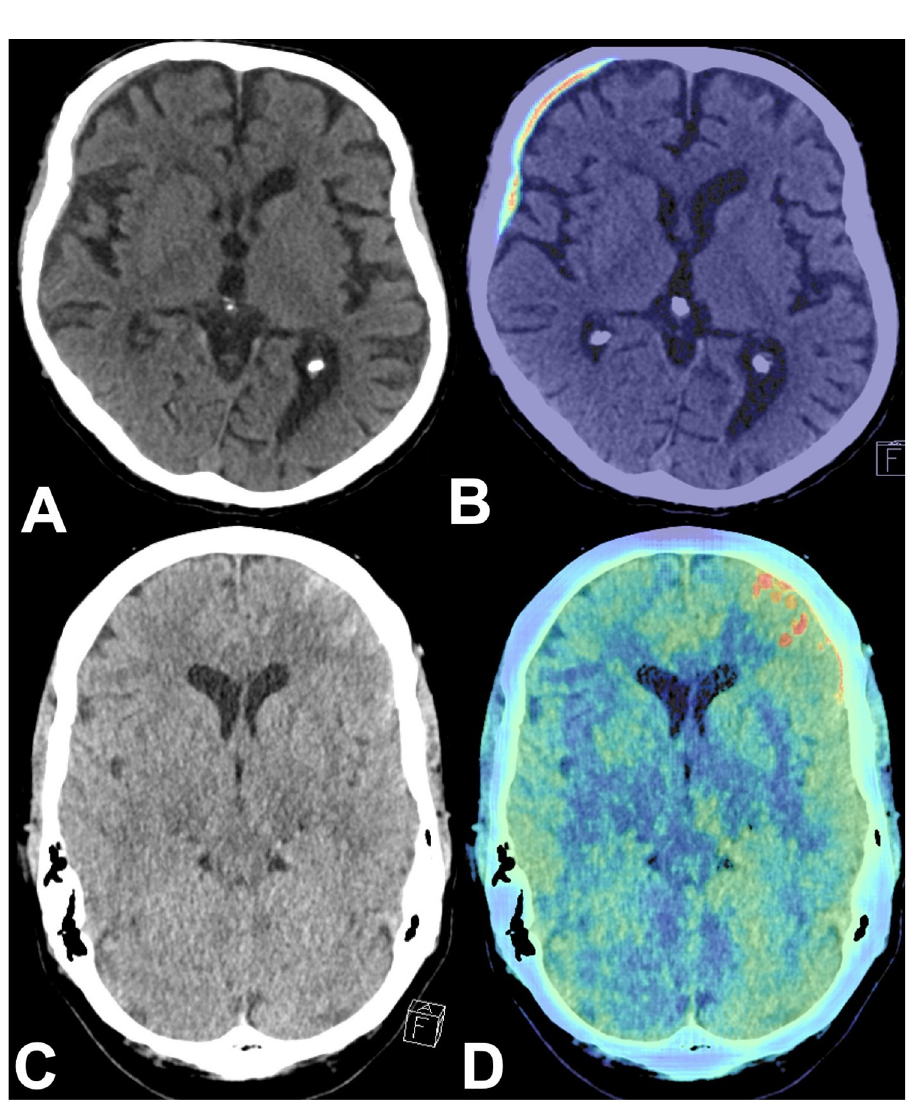
Fig 2. Color-coded maps. Axial non-contrast HCT showing a thin SDH of the right frontotemporal hemisphere (A) and a traumatic SAH of the left frontal and temporal lobe (C). B and D: AI analysis results as color-coded maps identifying the relevant findings (ICH) correctly (HCT, head computed tomography, SDH, subdural hematoma; SAH, subarachnoid hemorrhage; AI, artificial intelligence; ICH, intracranial hemorrhage).